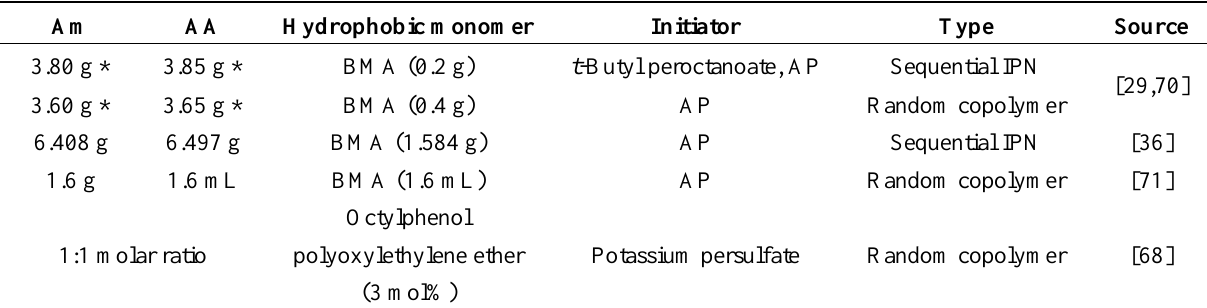
Table 2. Various recipes for hydrogels incorporating hydrophobic monomer.